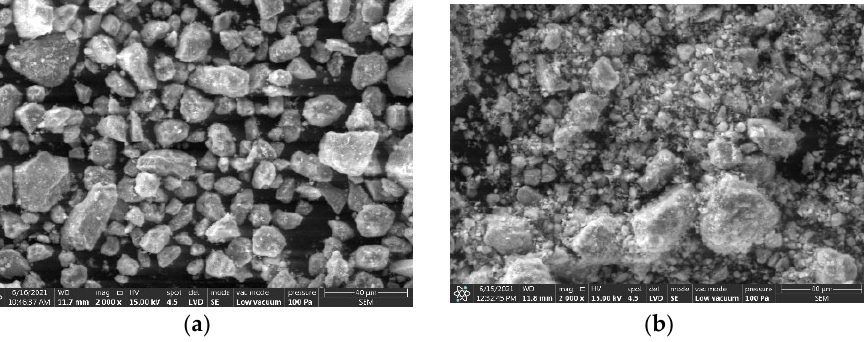
Figure 8. SEM images of Ukrainian clinoptilolite powder ( a ) and Slovakian clinoptilolite powder ( b ).